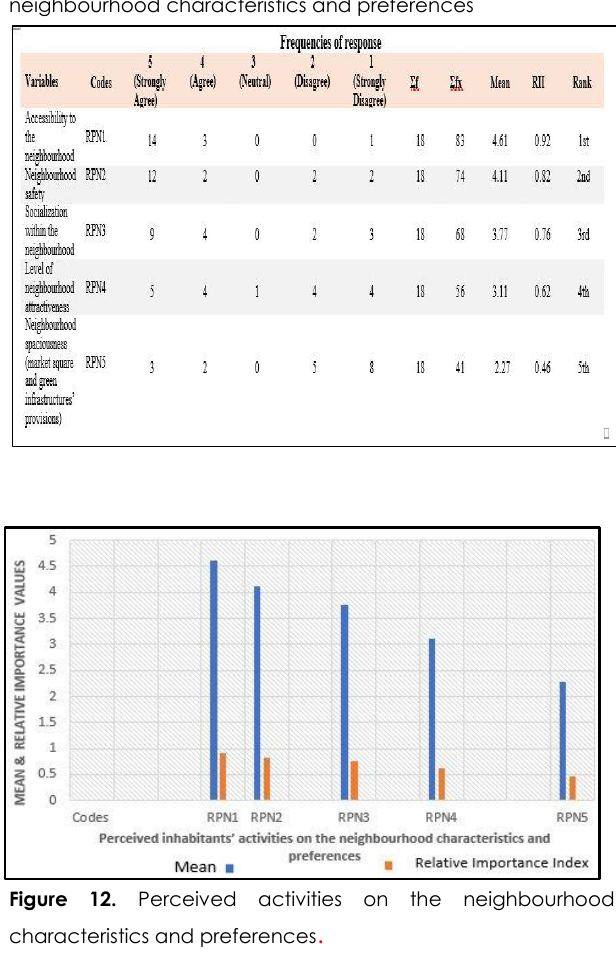
Table 1. Result of the perceived inhabitants’ activities on the neighbourhood characteristics and preferences